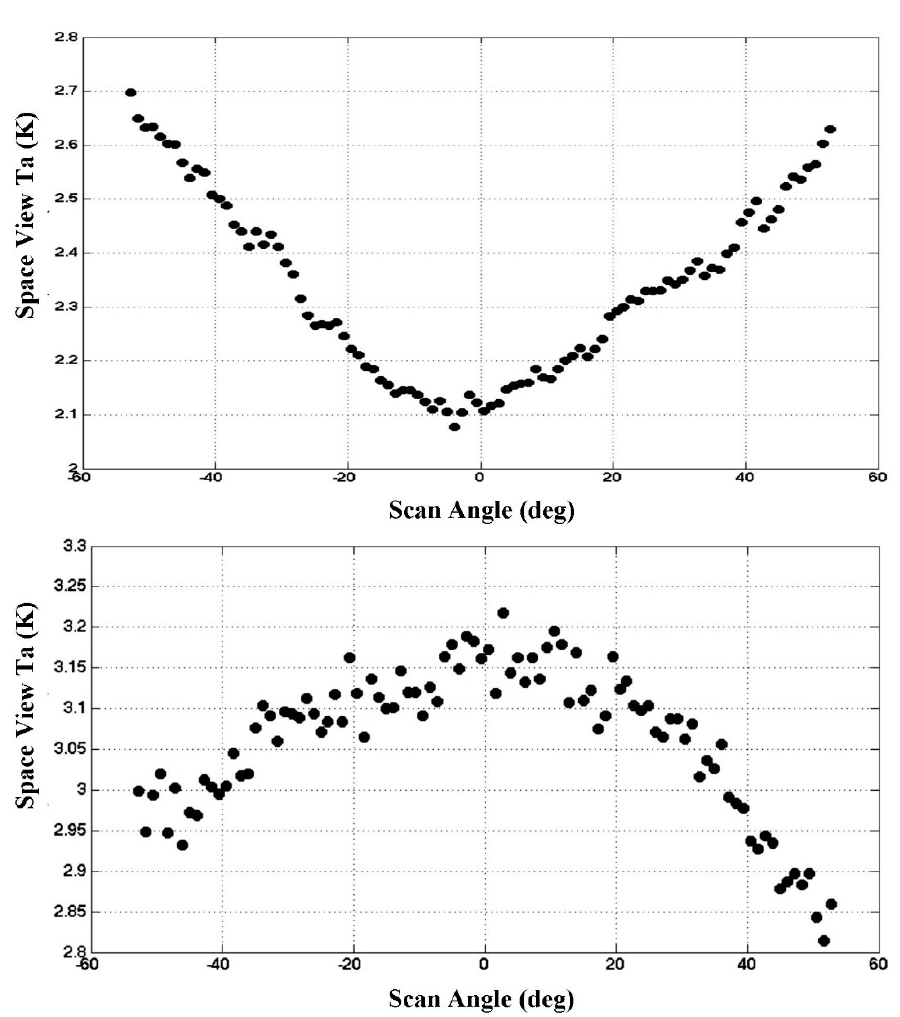
Figure 4. Examples of Suomi NPP ATMS mean brightness temperature vs. scan angle for channels 1 ( upper panel ) and 3 ( lower panel ) derived from the pitch maneuver observations. Table 6. On-orbit calibration accuracy derived from pitch maneuver data compared with those from the PFM error budget model at the cold scene. The pitch maneuver data at the center location is compared with the truth (2.728 K) for defining the on-orbit calibration accuracy.